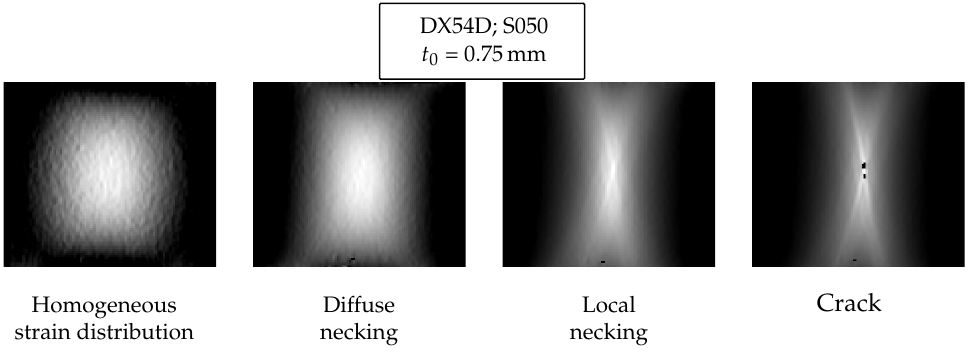
Figure 5. Forming phases guideline for the Nakajima